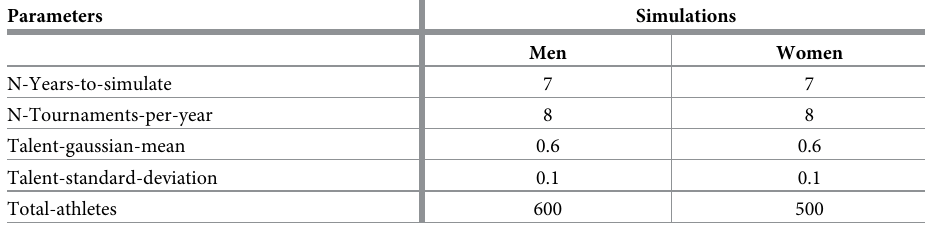
Table 3. The fixed set of parameters for each simulation